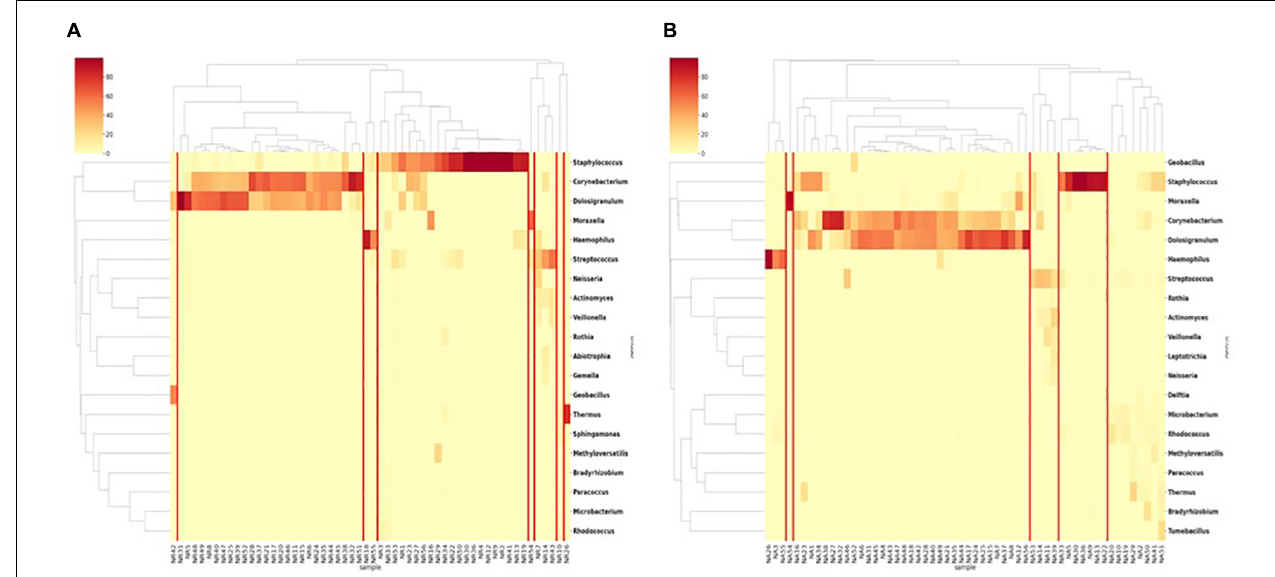
FIGURE 2 | Clustering of nasal samples (A) in the RP and (B) during AE based on genus level